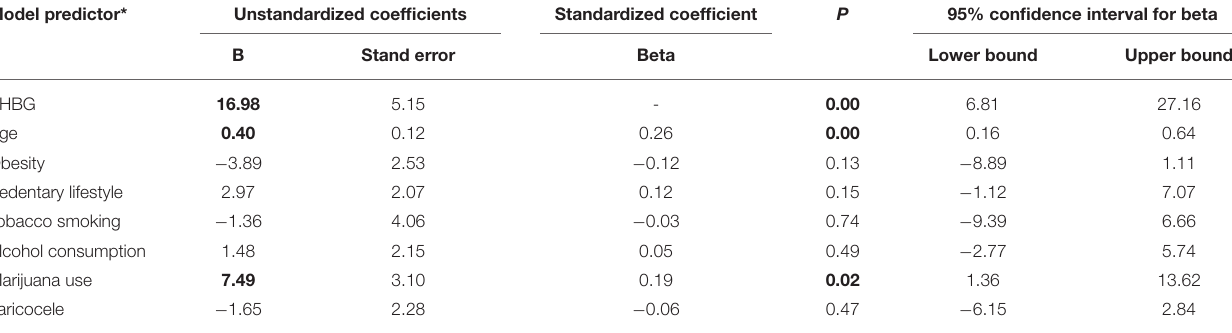
TABLE 7 | Coefficients of the multiple linear regression analysis model for dependent variable SHBG. Model predictor* Unstandardized coefficients Standardized coefficient P